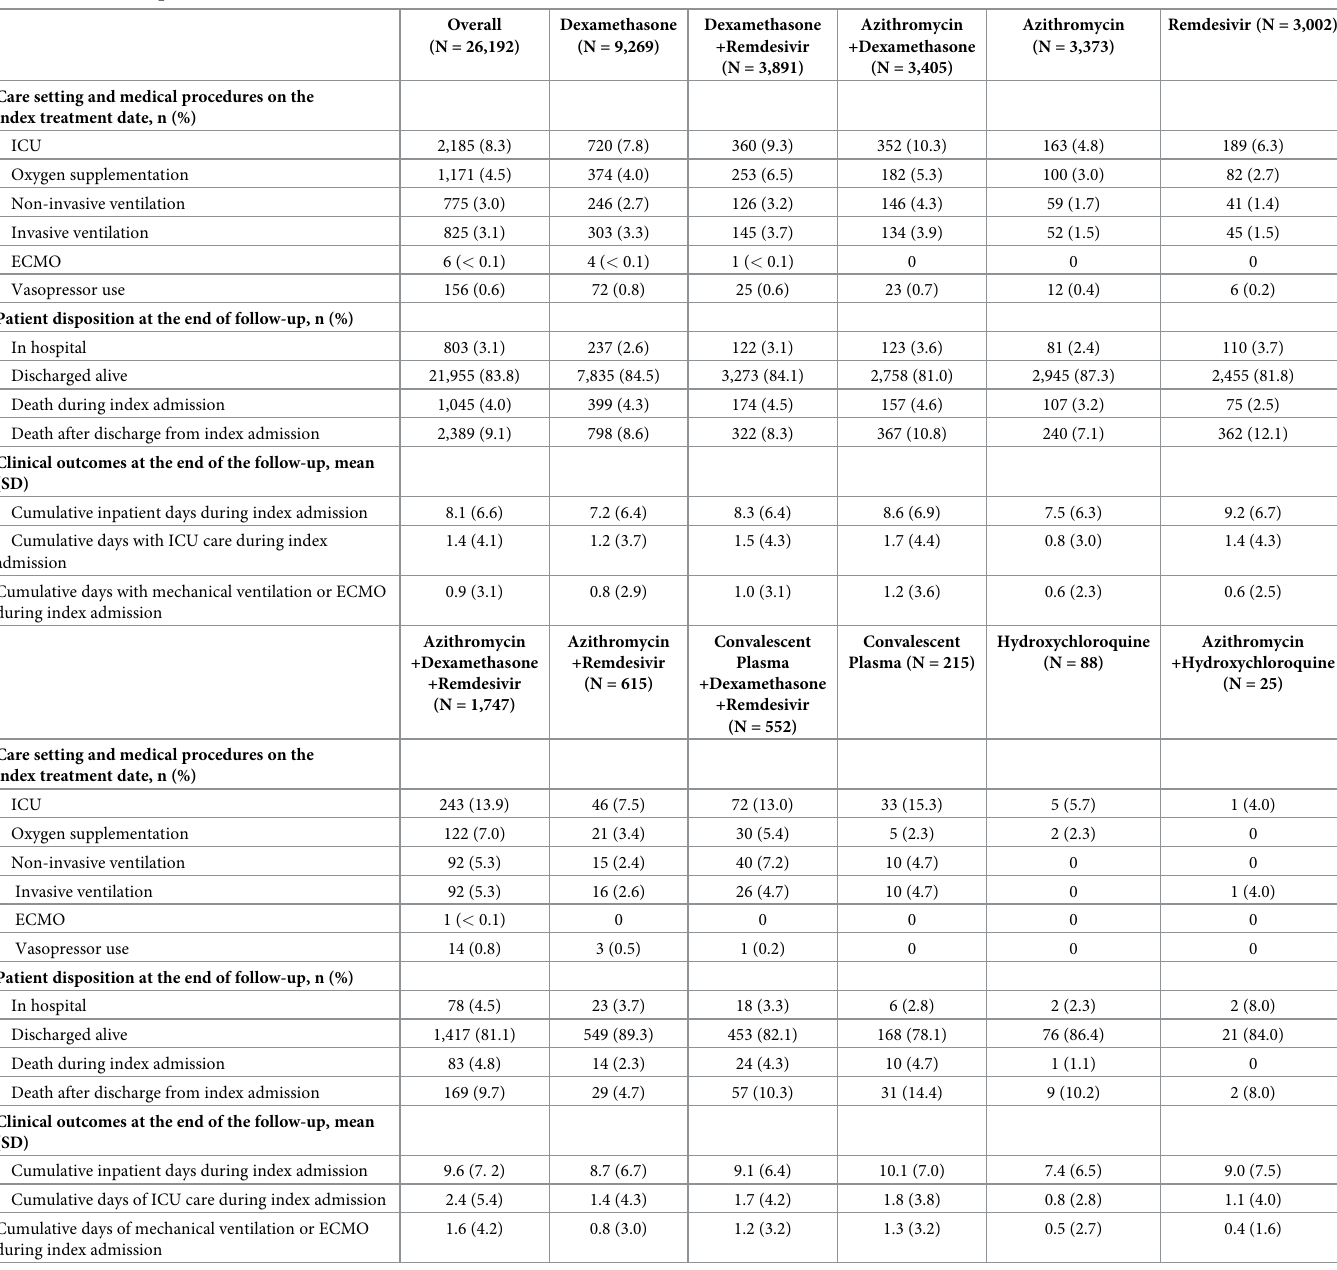
Table 2. Patient disposition and resource